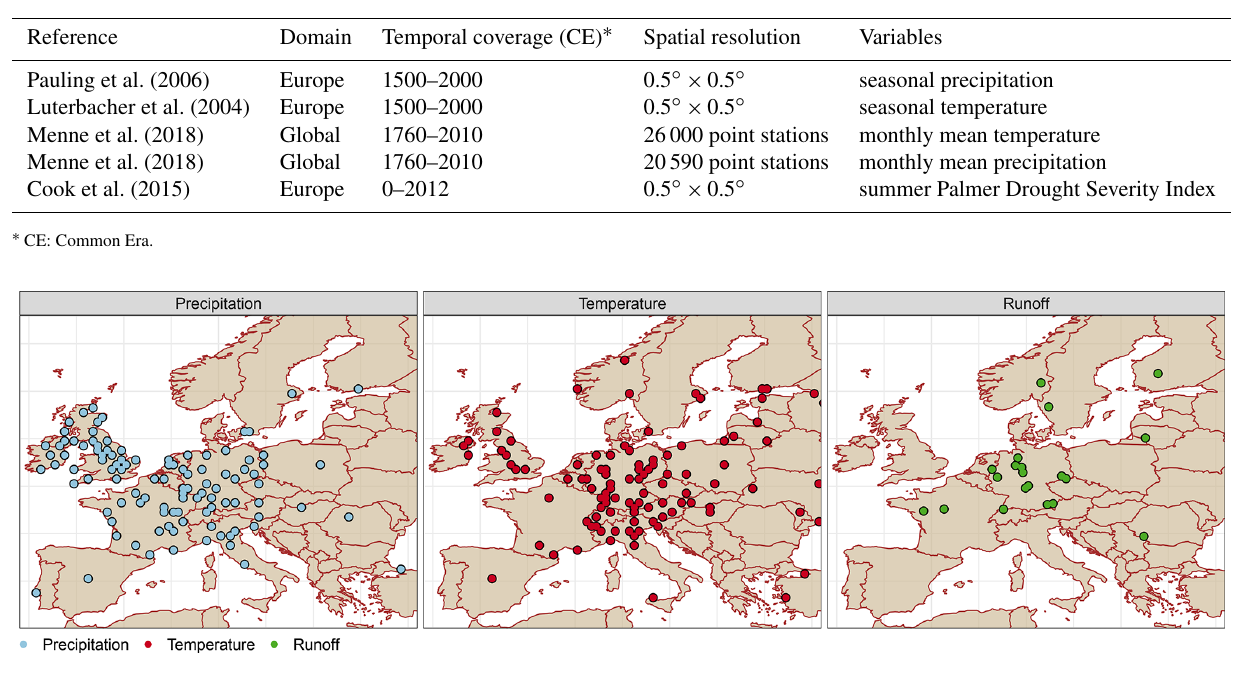
Figure 1. Spatial distribution of the observed GHCN precipitation and temperature stations and GRDC runoff gauges.